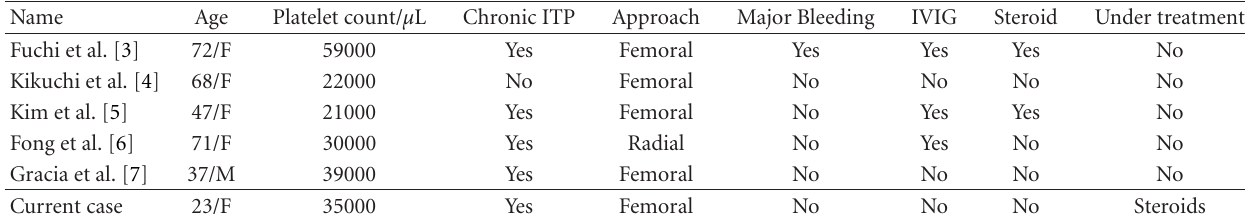
Figure 2: Coronary angiography of the left coronary artery. (a) Total obstruction in the proximal left anterior descending artery (LAD). (b) Dilation. (c) After balloon angioplasty. (d) After stent implantation, PCI was successful. Table 1: Case reports of AMI with ITP treated with primary